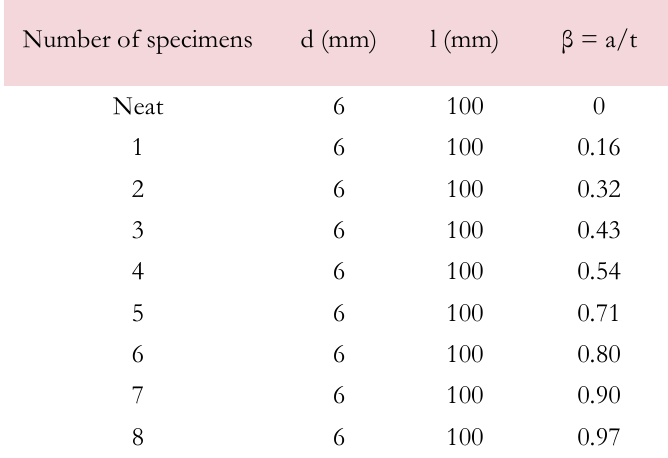
Table 1: Burst pressure evolution in function of the life fraction.